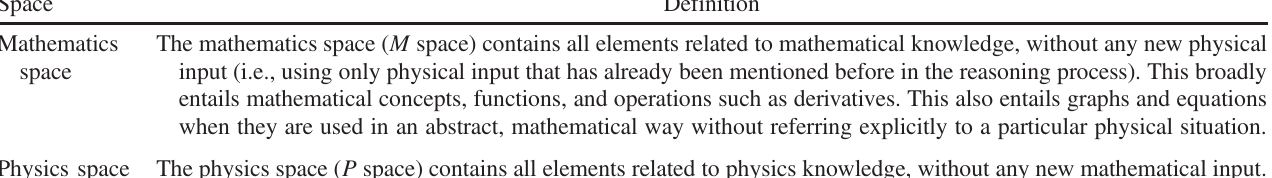
TABLE I. Definitions of the different mental spaces used in this study. Space